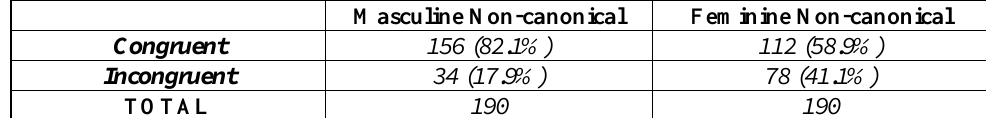
Table 5. Distribution of responses from forced-choice judgment task for non-canonical ending